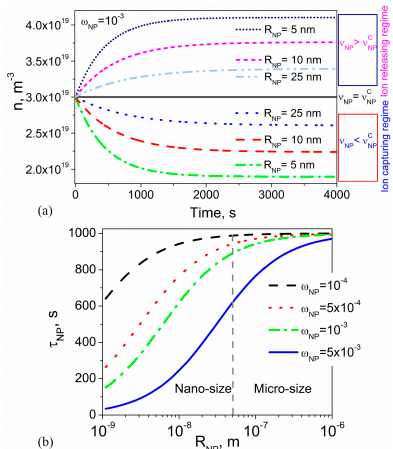
Figure 2. ( a ) The volume concentration of mobile ions n versus time calculated using different values of the nanoparticle radius R NP ( R NP = 5nm (dotted-dashed and short-dotted curves); R NP = 10nm (dashed and short-dashed curves), R NP = 25nm (dotted and dashed-dotted-dotted curves) and their contamination factor ν NP ( v NP = 10 − 4 (dotted, dashed, and dotted-dashed curves); v NP = 3 × 10 − 4 (solid curve); v NP = 5 × 10 − 4 (dashed-dotted-dotted, short-dashed, and short-dotted curves)). The weight concentration of nanoparticles ω NP is 10 − 3 ; ( b ) The time constant τ NP as a function of the radius of nanoparticles R NP calculated at different values of their weight concentration ω NP ( ω NP = 10 − 4 (dashed curve); ω NP = 5 × 10 − 4 (dotted curve); ω NP = 10 − 3 (dashed-dotted curve); ω NP = 5 × 10 − 3 (solid curve)). Other parameters used in simulations: K NP = 10 − 23 m 3 , (cid:14) = 10 − 3 s − 1 , σ NP = 0.8 × 10 18 m − 2 , n = 3 × 10 19 m − 3 , ρ k NP ρ LC = NP 0 S d